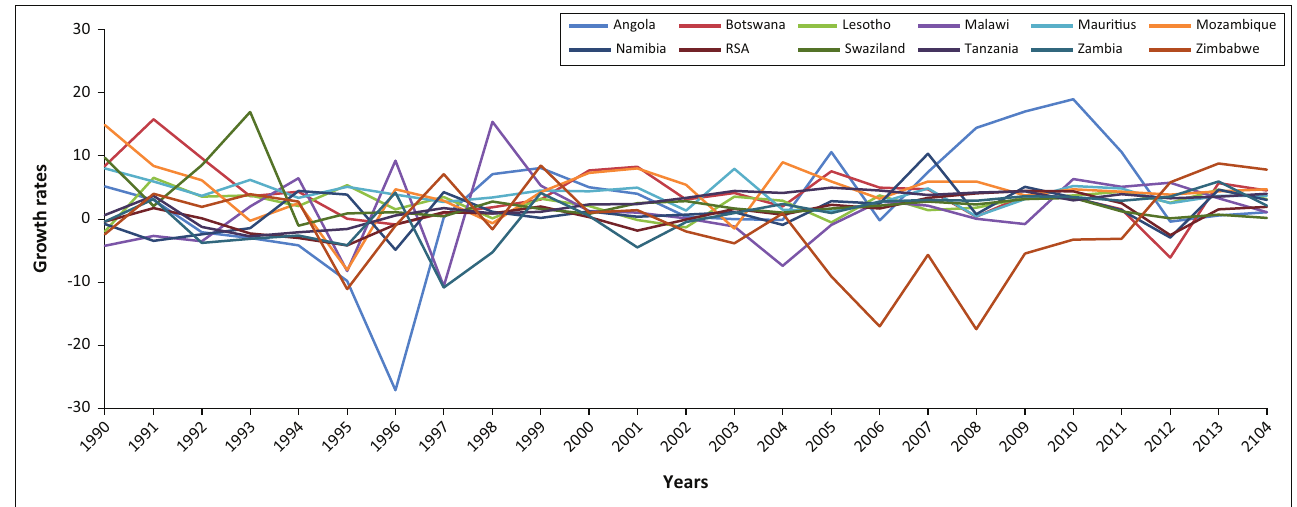
FIGURE 1: Southern African Development Community growth rates